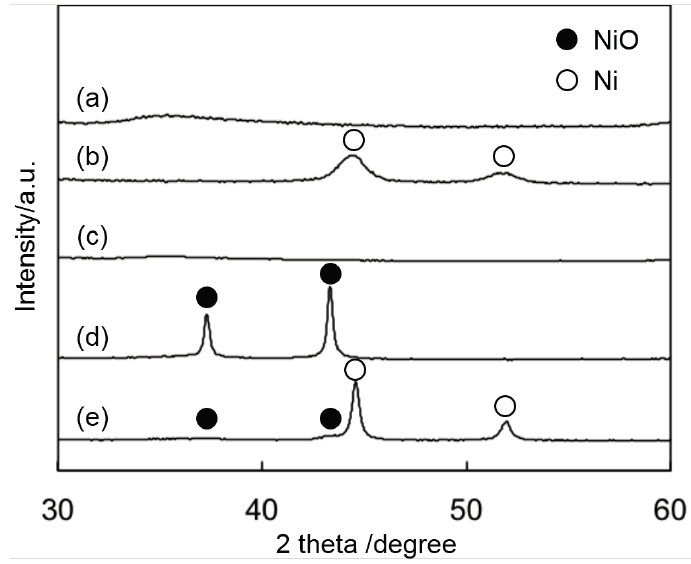
Figure 1. XRD patterns of SM(Ni35) before reduction (a) and after reduction (b); SM after calcination (c); Ni35/SM before reduction (d) and after reduction